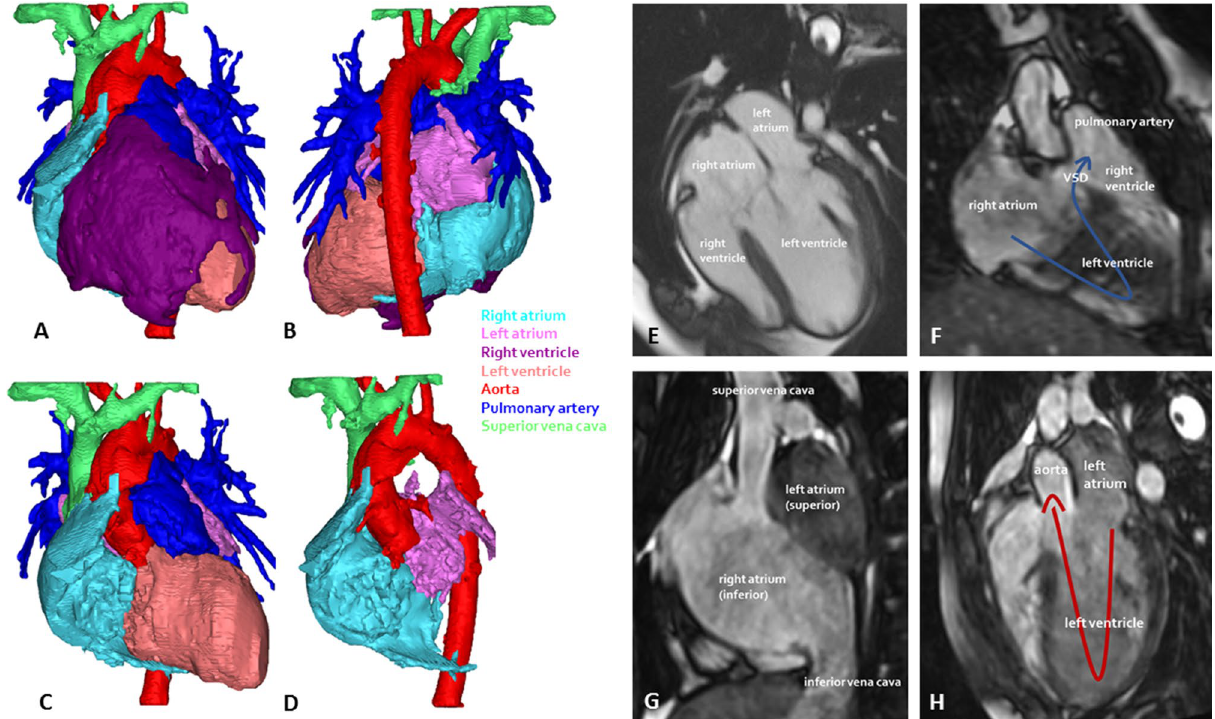
Figure 2. Anatomy of double inlet left ventricle patient 2. ( A ) Anterior view, complete. ( B ) Posterior view, complete. ( C ) Anterior view, right ventricle removed. ( D ) Both ventricles removed, appreciate anterior/posterior relationship of atria. ( E ) 4-chamber view. ( F ) Pathway of oxygen-poor blood stream. ( G ) Superior-inferior relationship of the atria. ( H ) Pathway of oxygen-rich blood stream. VSD, ventricular septal